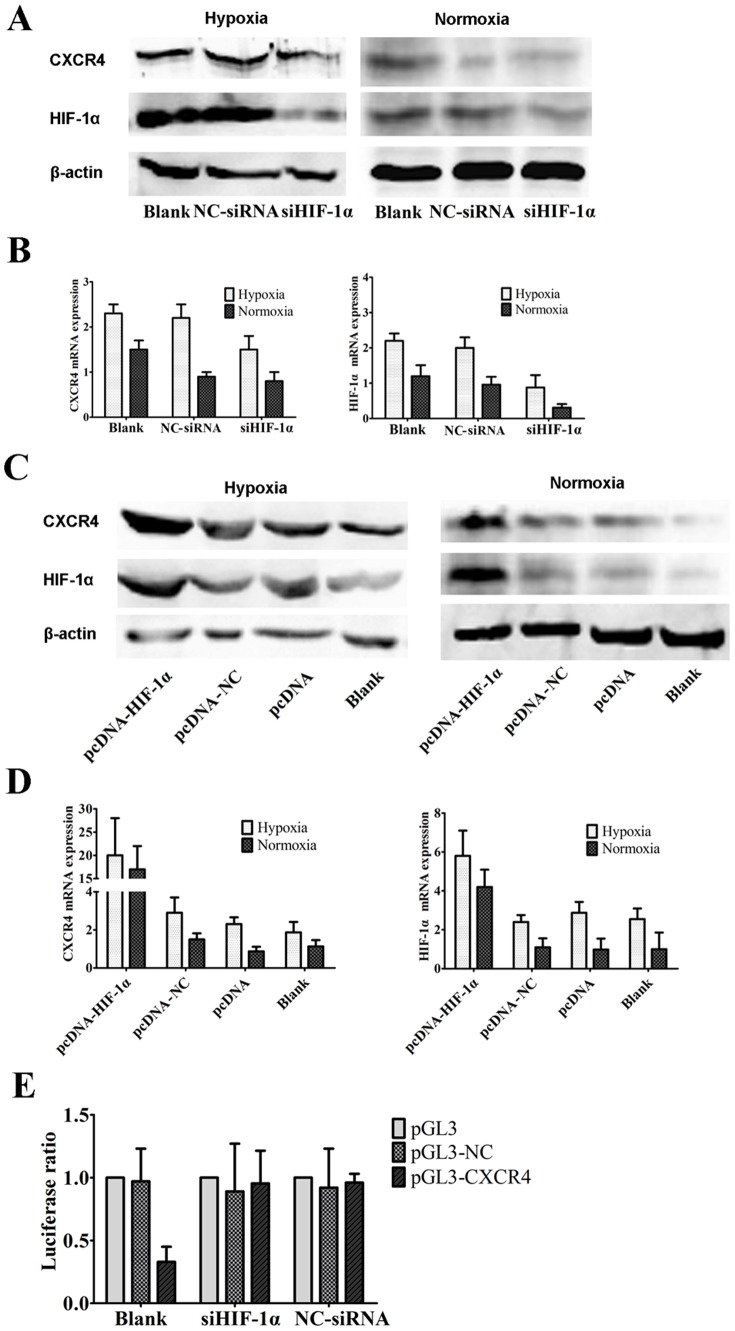
CXCR4 expression was regulated by HIF-1α.SOSP-9607 cells were transfected with siHIF-1α or NC-siRNA- and then exposed to both hypoxia and normoxia. Forty-eight hours after transfection, the protein levels of CXCR4 and HIF-1α (A) were analyzed by Western blot. β-actin was used as a loading control. In addition, the expression of CXCR4 and HIF-1α (B) mRNA was analyzed by quantitative real-time PCR. SOSP-9607 cells were transfected with pcDNA-HIF-1α or mock (pcDNA-NC) and then exposed to both hypoxia and normoxia. The pcDNA plasmid and untransfected cells (Blank) were used as a control. Forty-eight hours after transfection, the protein levels of CXCR4 and HIF-1α (C) were analyzed by Western blot. β-actin was used as a loading control. The expression of CXCR4 and HIF-1α (D) mRNA was analyzed by quantitative real-time PCR. E. A luciferase reporter plasmid with the CXCR4 promoter (pGL3-CXCR4) or a control (pGL3-NC) was co-transfected with siHIF-1α into SOSP-9607 cells. Twenty-four hours later, luciferase activity was measured using a dual luciferase reporter assay (Promega, USA). The results are presented as the means ± SDs of three independent experiments.